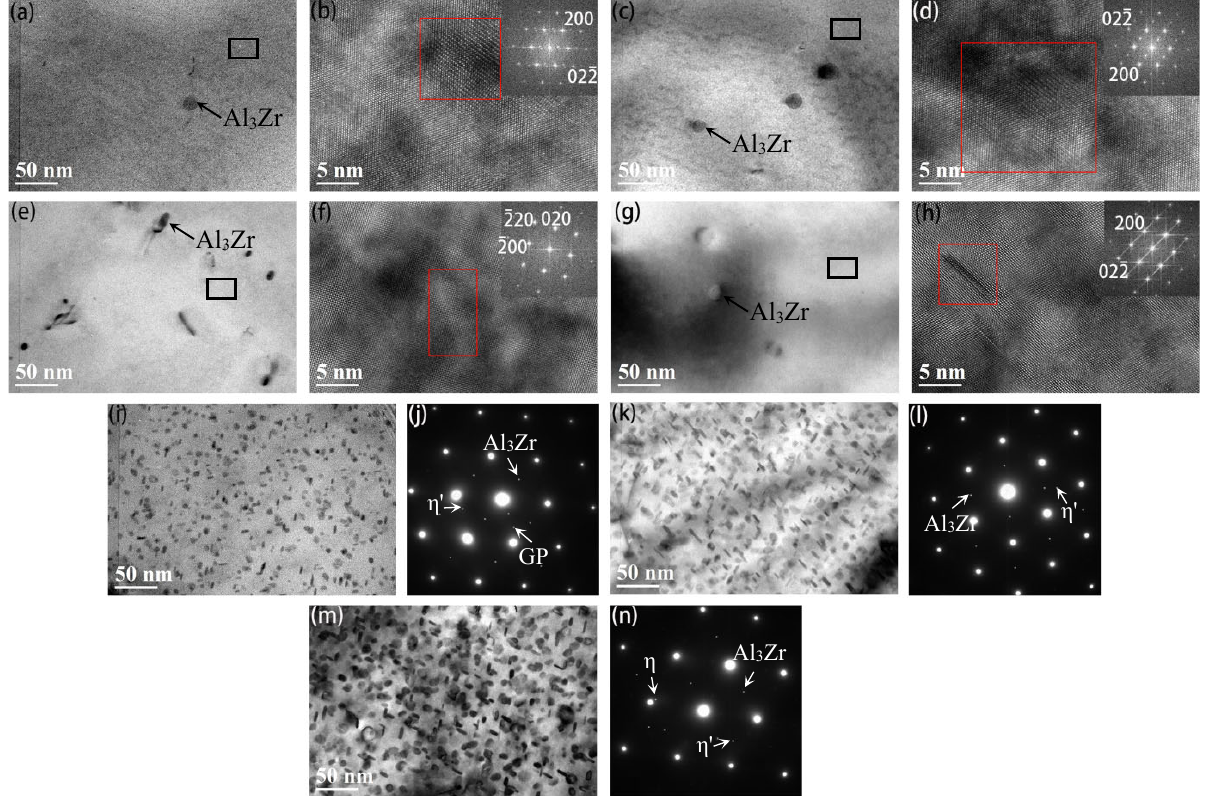
Figure 5. BF ‐ TEM and HREM images of 7005 aluminum alloy plate matrix precipitates along the [110] Al ( a – d , g – n ) and [100] Al ( e , f ) orientation aged at 120 °C for different durations: ( a , b ) 1 h, ( c , d ) 4 h, ( e , f ) 8 h, ( g , h ) 12 h, ( i , j ) 24 h, ( k , l ) 96 h, and ( m , n ) 192 h. Note: ( b , d , f , h ) are the extracted HREM images of the black boxes in ( a , c , e , g ), respectively, and the red boxes in ( b , d , f , h ) are the Fast Fourier Transformation (FFT) pattern areas in the upper right corner.